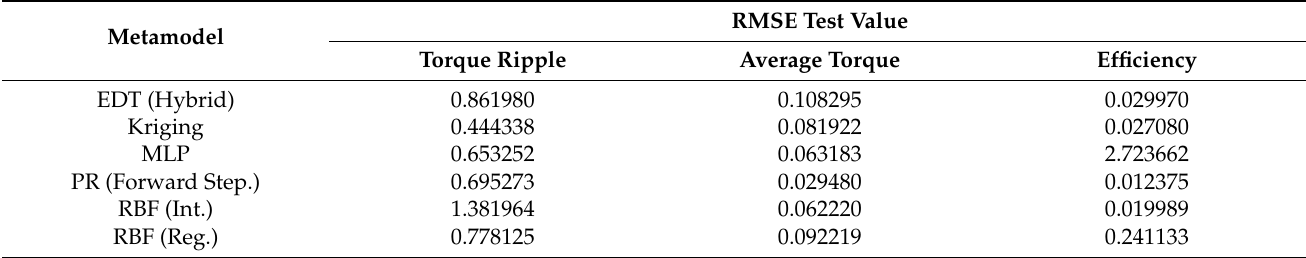
Table 3. RMSE test results of the metamodels for different output variables.